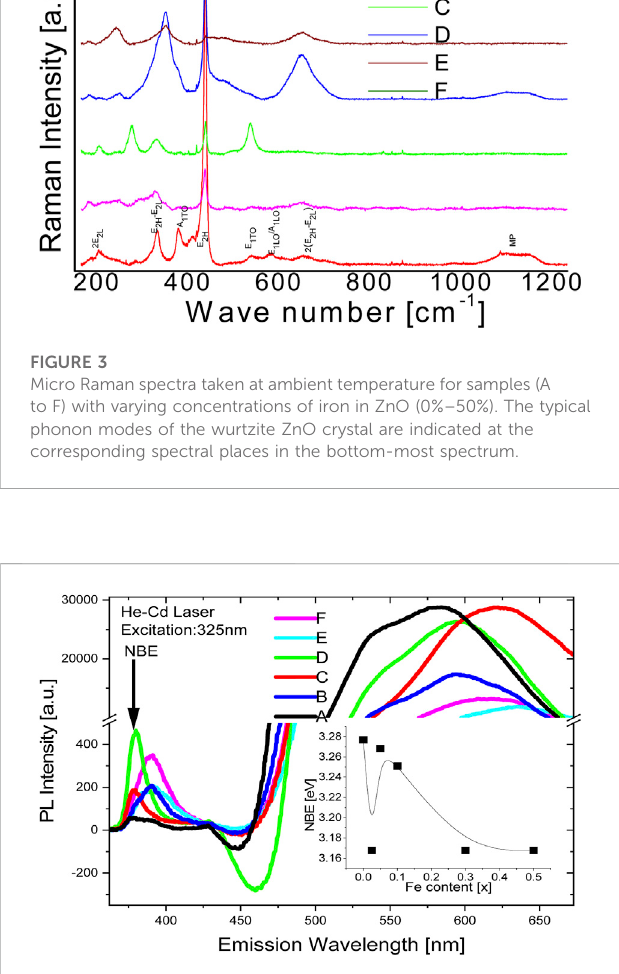
Figure 4 ’ s inset demonstrates how the energy-gap dependence on “ x" work. Any change in NBE emission energy is typically proportional to the energy gap Eg of Zn 1-x Fe x O since Fe 2 O 3 has a lower energy gap of 2.5 eV (Schrettle et al., 2012). It is clear that the relationship between Eg and Fe percentage in Zn1-xFexO does not adhere to a typical band- gap dependence of the kind given by Vigard ’ s formula E g ( ZnFeO ) (cid:2) xE g ( ZnO ) + ( 1 − x ) E g ( FeO ) − bx ( 1 − x ) , where the bending parameter is b (Wang and Tanaka, 2009; Jaquez et al., 2015; Kumar et al., 2015). Since the Zn1-xFexO system de fi e Vigard ’ s law, the NBE red-shift